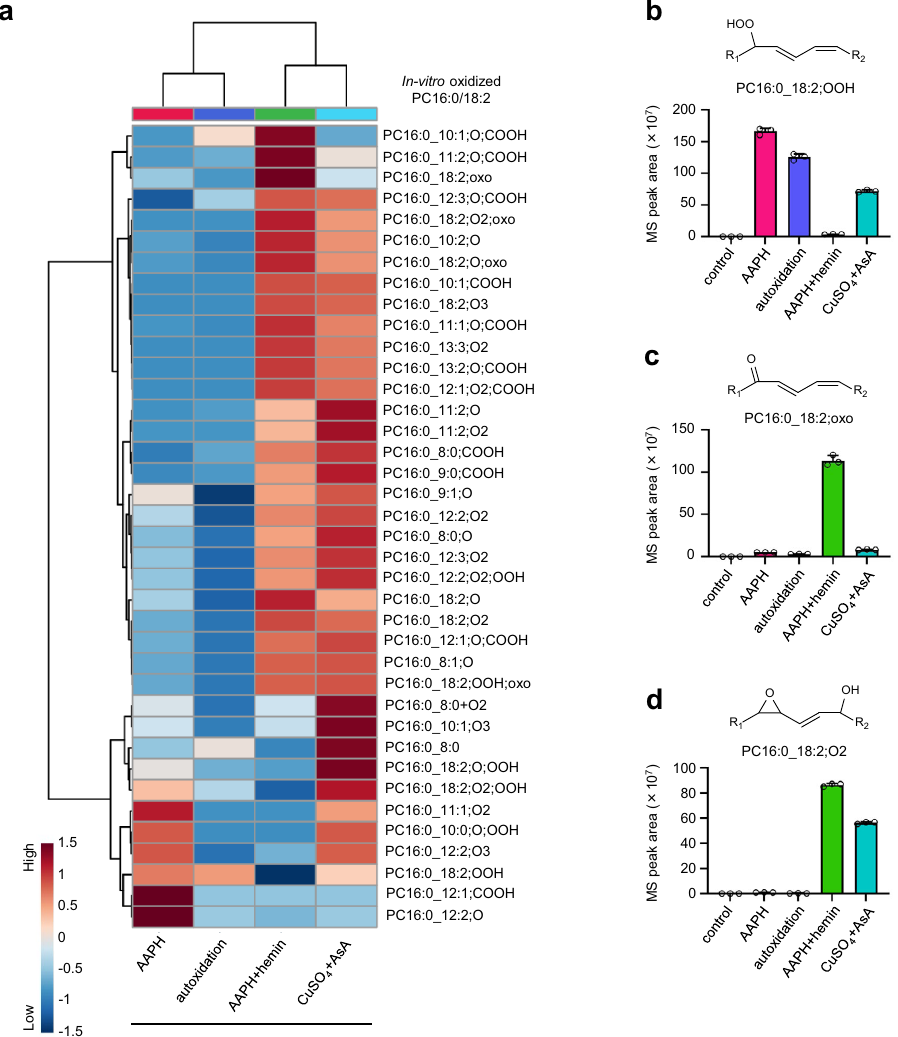
Fig. 2 Diversity of oxidized PC16:0/18:2 formed in several in vitro peroxidation systems. a Hierarchical cluster analysis of oxidized PC16:0/18:2 was generated in several peroxidation systems in vitro. The color re fl ects normalized MS peak area of each oxPC using log 10 transformation and autoscaling. b – d MS peak areas of typical oxidized PC16:0/18:2 observed in each LPO system. b PC16:0_18:2;OOH, c PC16:0_18:2;oxo, and d PC16:0_18:2;O2. Data are presented as the mean + standard deviation of three repeated experiments. MS peak area of each adduct is calculated from the corresponding extracted ion chromatogram peak area. LC/HRMS/MS data were obtained by using parallel reaction monitoring (PRM) in the negative ion mode. Source data are provided as a Source Data fi